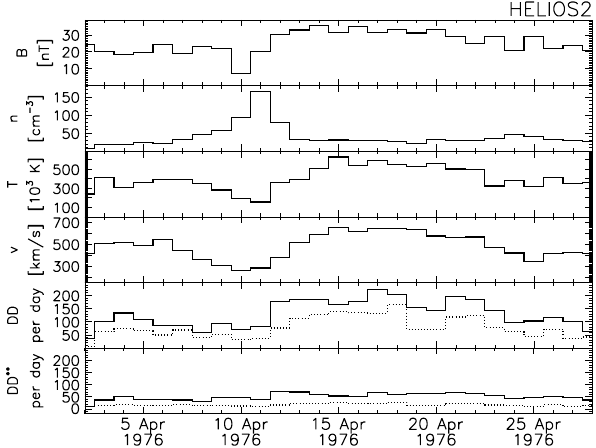
Fig. 2. Daily averages of B , n , T , v and the rates DD per day and DD ?? per day for the TS (solid) and B (dashed) criteria, respec-